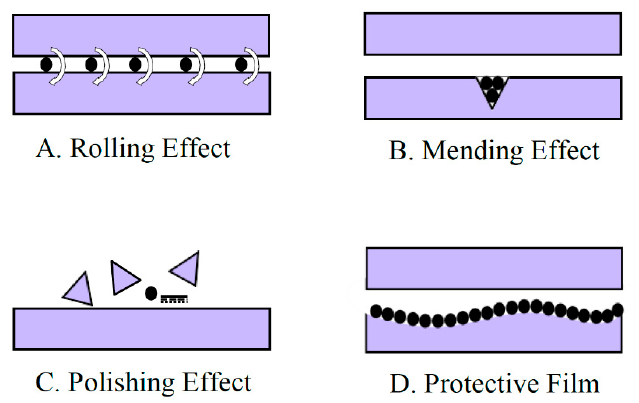
Figure 2. Lubrication mechanisms of nanoparticles. ( A ) Rolling Effect; ( B ) Mending Effect; ( C ) Polishing Effect; ( D ) Protective Film.